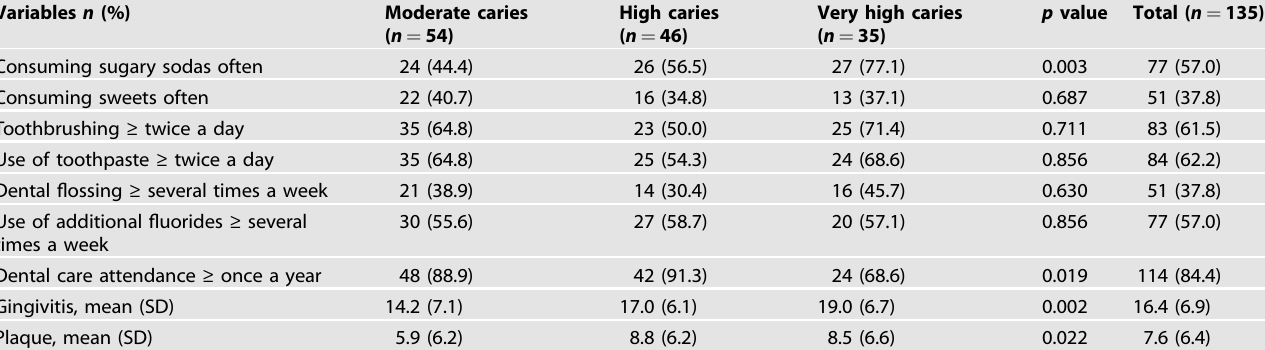
Table 2. Oral health behaviors and clinical parameters according to caries severity: moderate caries (2 – 3 lesions), high caries (4 – 6 lesions), very high caries ( ≥ 7 lesions), and for the total